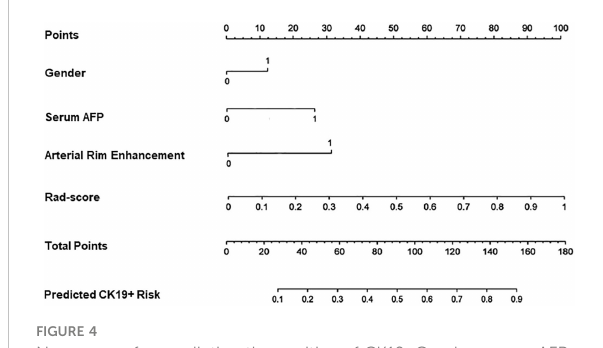
FIGURE 4 Nomogram for predicting the positive of CK19. Gender, serum AFP and arterial rim enhancement were the risk factors. For gender “ 0 ” refers to male, ” 1 ” refers to female. For arterial rim enhancement, “ 0 ” refers to absence of the feature and “ 1 ” refers to presence of it. “ Rad-score ” is the prediction of CK19 status of the fusion radiomics model. “ Total points ” is the total score by adding gender, serum AFP, arterial rim enhancement, and rad-score.